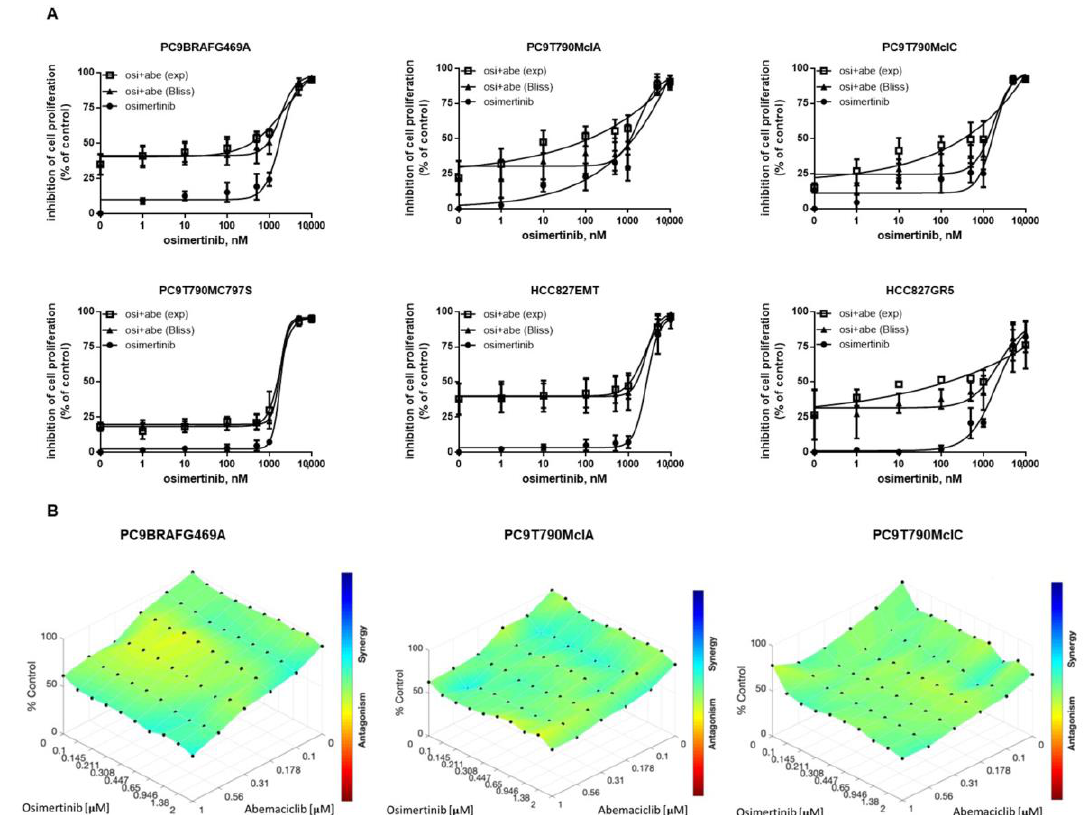
Figure 2. Effects of the combined treatment of abemaciclib with osimertinib on cell proliferation. ( A ) The indicated cells were treated with different concentrations of osimertinib in absence or in presence of 500 nM abemaciclib. After 72 h cell proliferation was assessed by MTT assay and the effect of the drug combination was evaluated using the Bliss interaction model. Data are expressed as percent inhibition vs. control cells and are means ± SD of at least three separate experiments. ( B ) Drug interaction heatmaps for osimertinib and abemaciclib combination treatment in PC9BRAFG469A, PC9T790MclA, and PC9T790MclC